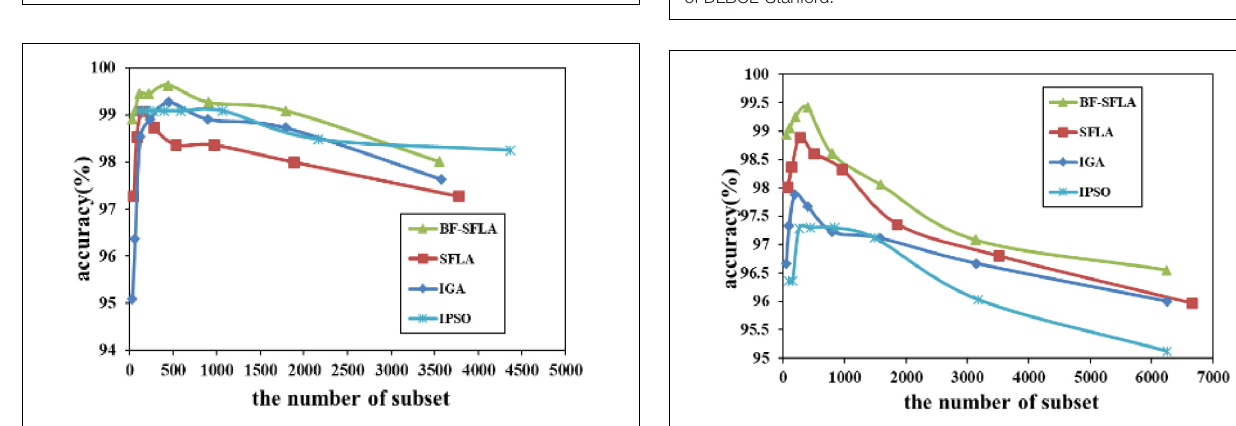
FIGURE 7 | The variation trend of classification accuracy and feature subset of ALL-AML-Leukemia.